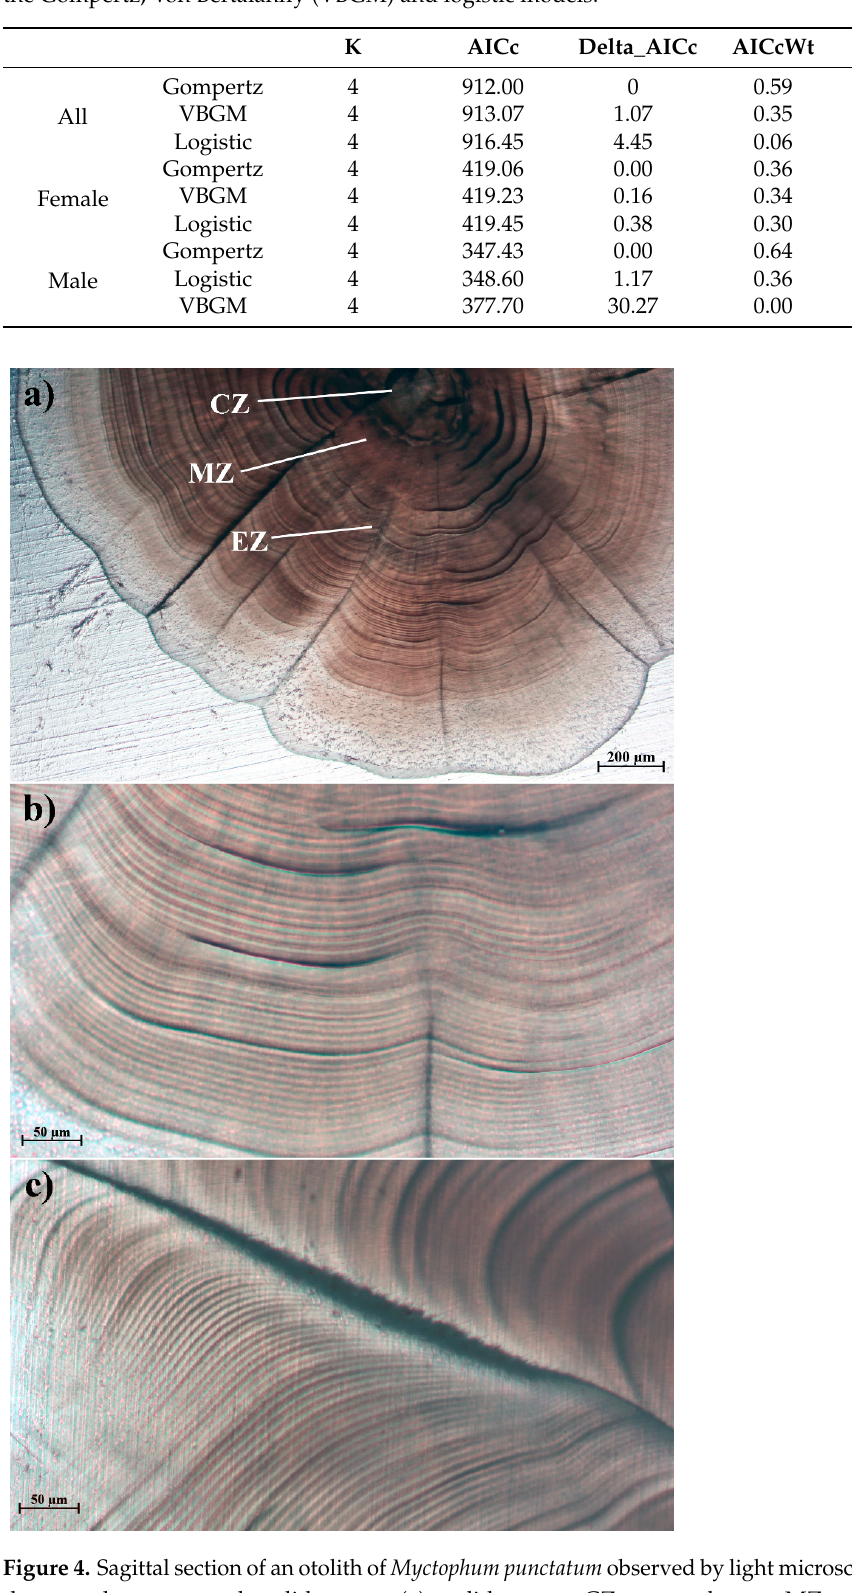
Table 2. Model selection based on AICc results for the general (all data) and gender data relative to the Gompertz, Von Bertalanffy (VBGM) and logistic models.